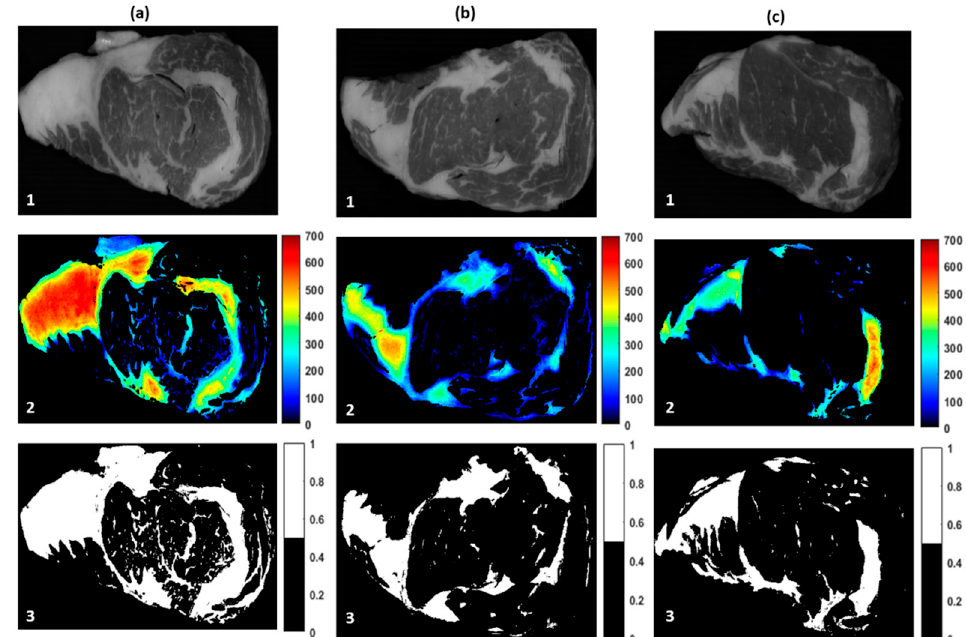
Figure 5. Sample visualization of the PDS-DA model using beta coefficients and original HSI images. ( a1 – c1 ) represents the original HSI images for Akaushi prime, USDA prime, and USDA choice, respectively. ( a2 – c2 ) represent the chemical image of the samples for Akaushi prime, USDA prime, and USDA choice, respectively. Converted binary images from the chemical images are presented in ( a3 – c3 ) for Akaushi prime, USDA prime, and USDA choice, respectively.